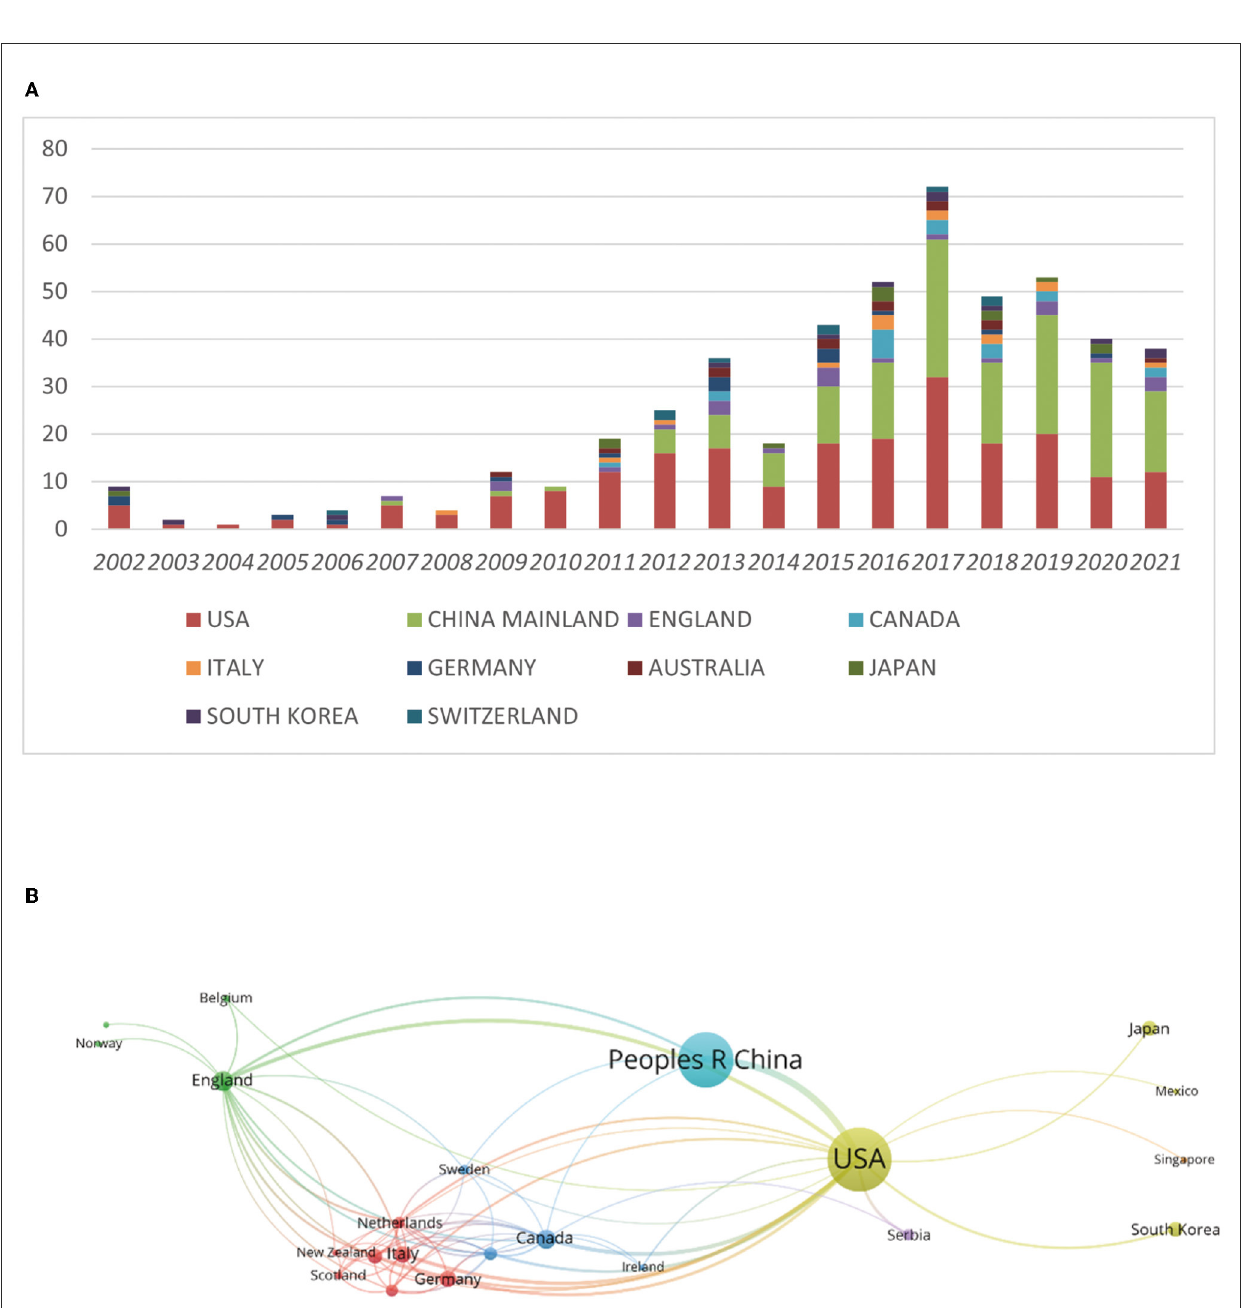
FIGURE2 The impact of year and country changes on the number of articles in the field of anesthesia’s neurotoxicity to the developing brain. (A) Evolution of the number of publications in the 10 most important countries. (B) Map of the various countries’ close cooperation.